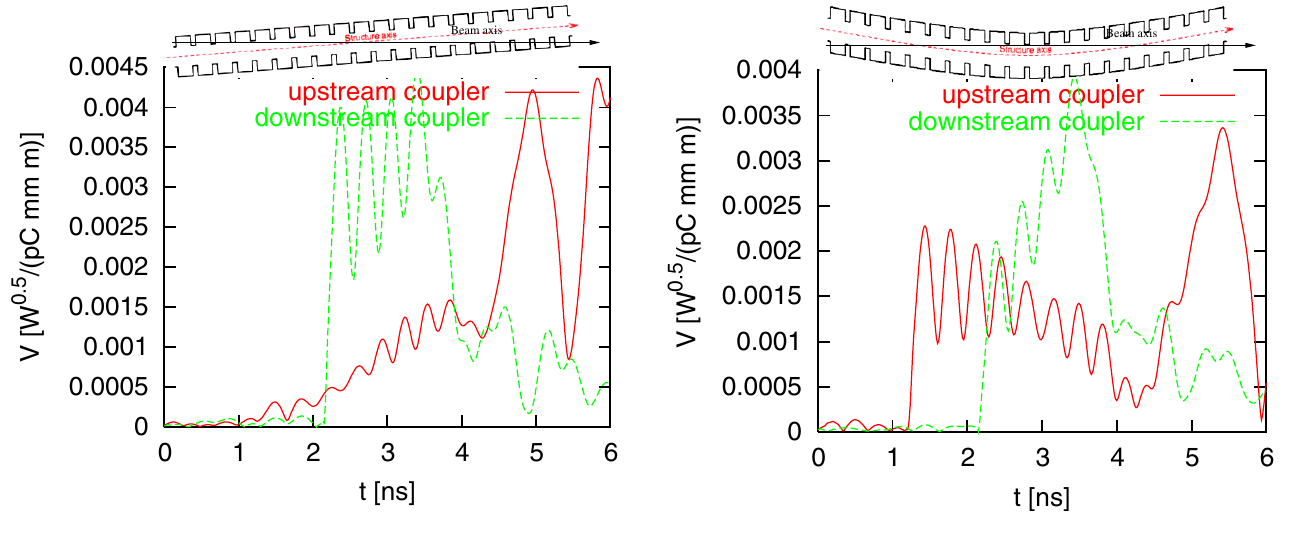
FIG. 12. (Color) Signal envelope upstream and downstream monitors vs time assuming bent structure.